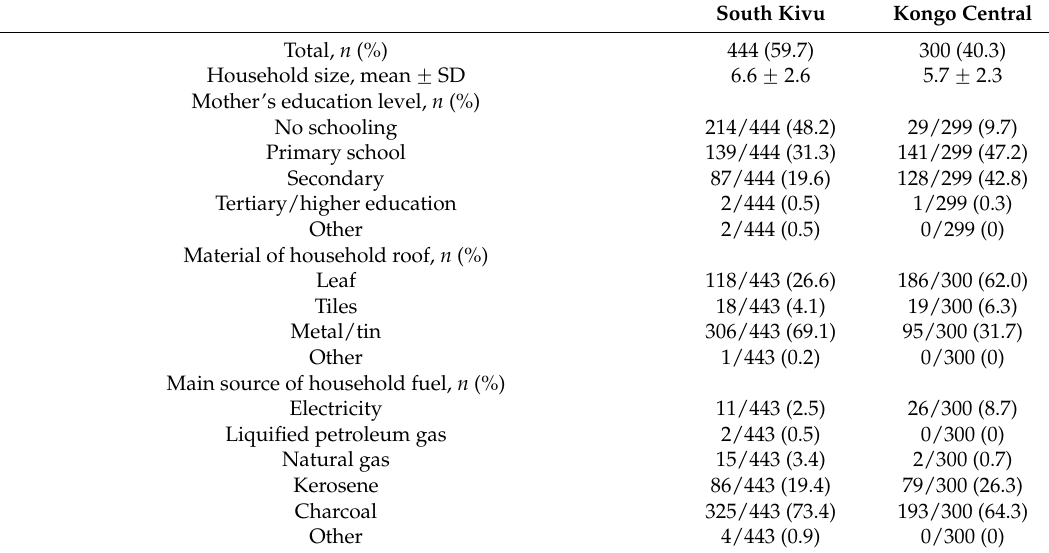
Table 1. Household characteristics of the study population in two provinces in the Democratic Republic of the